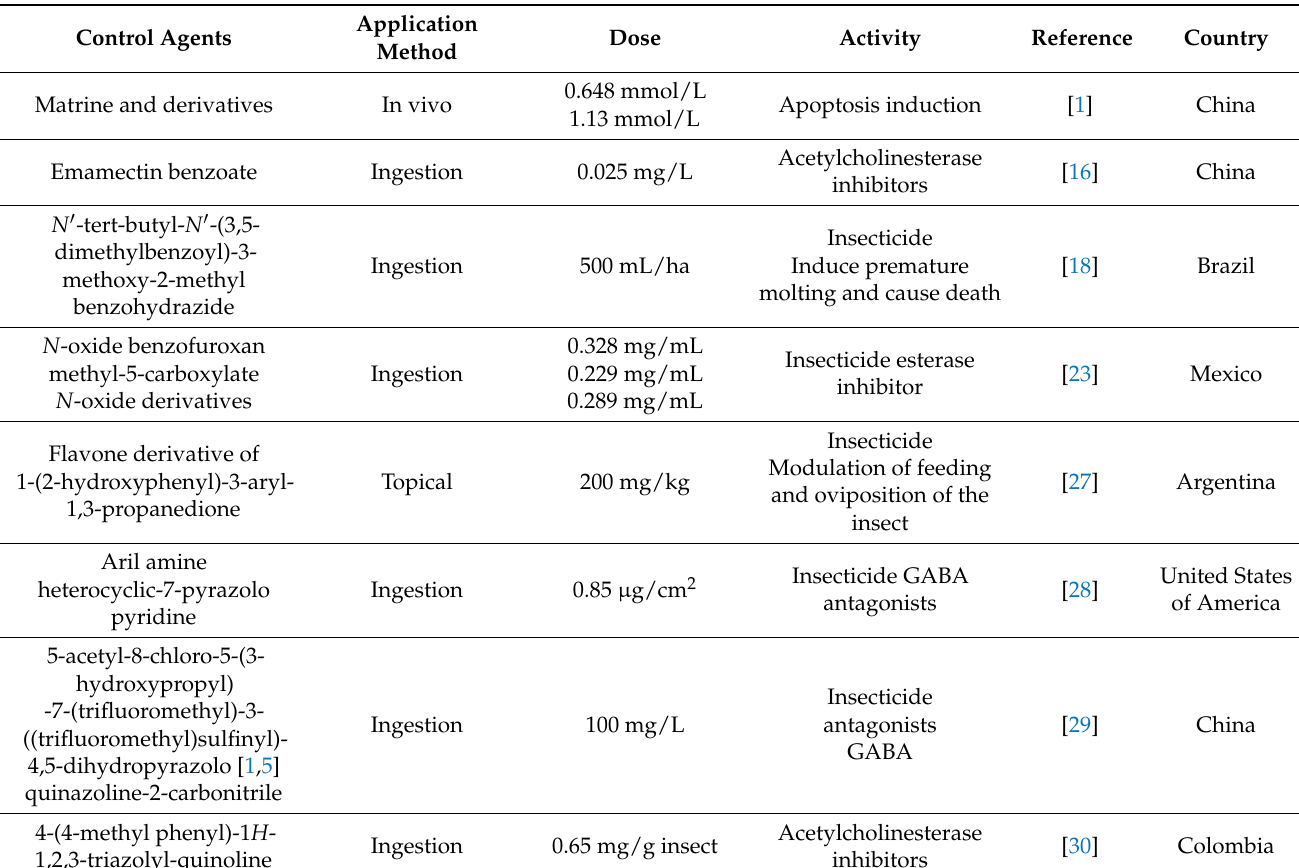
Table 1. Chemical agents with potential insecticidal activity against S. frugiperda